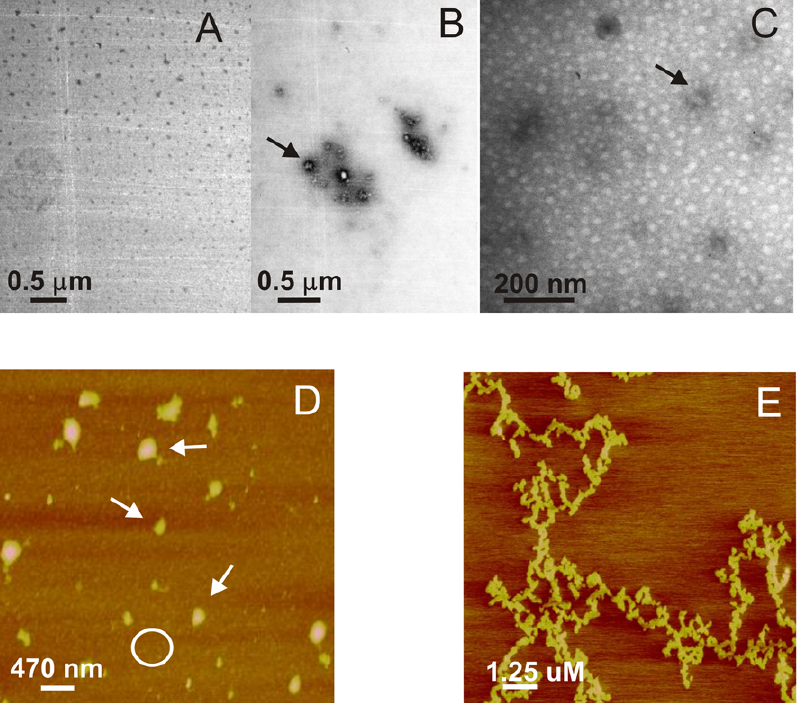
Figure 4. Morphology of pH-induced apoA-I aggregates. Panels illustrate representative images of apoA-I samples studied by transmission Electron Microscopy (A–C) and Atomic Force Microscopy (D,E) A) and B) Protein was incubated at 0.4 mg/mL and 37 u C for 24 h at pH 7.4 or pH 5.0, respectively. C) ApoA-I after 48 days incubation at 37 u C and pH 5.0. Black arrows in the figures indicate some of the oligomeric structures. D) ApoA-I (0.6 mg/mL) incubated at pH 5.0 for 24 h at 37 u C, and loaded onto mica. Small size oligomers covering the surface of the mica (represented by the white circle), plus some larger complexes (white arrows) predominated, and some long, thin, unstructured protofibers could also be observed (panel E). Scale bars are shown in each